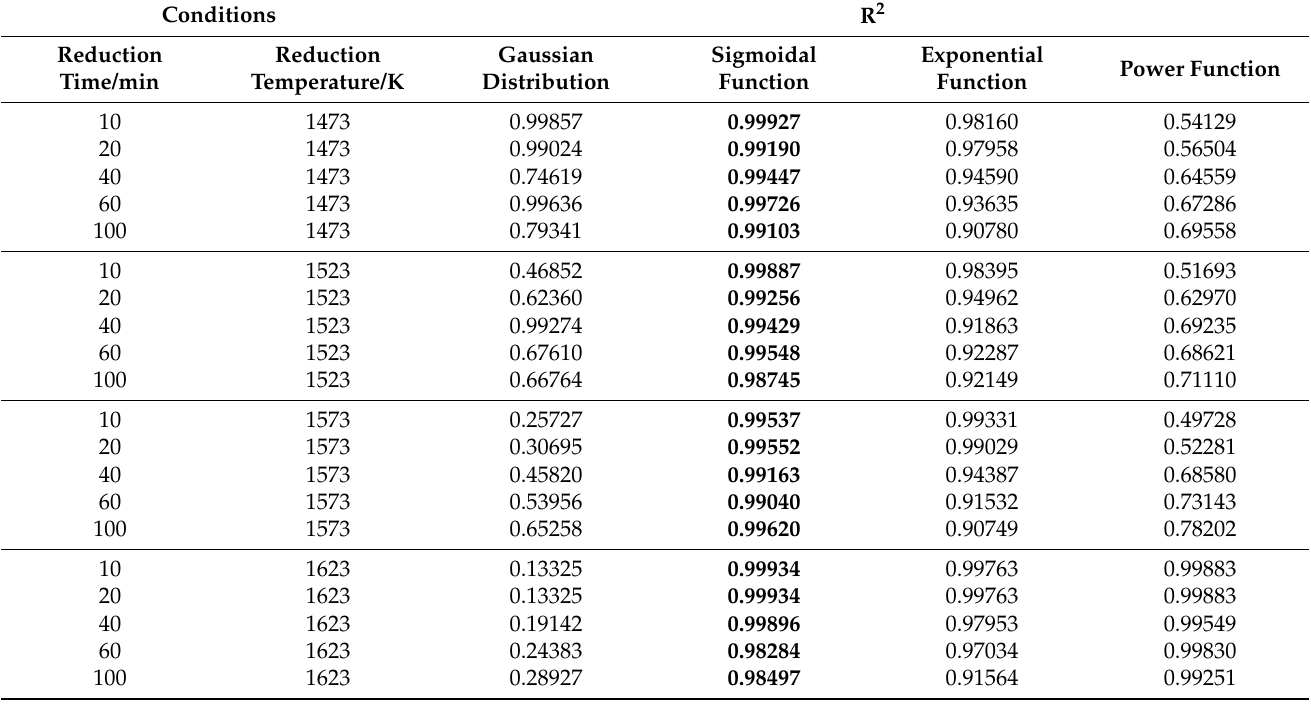
Table 3. Fitting results of the distributions of iron